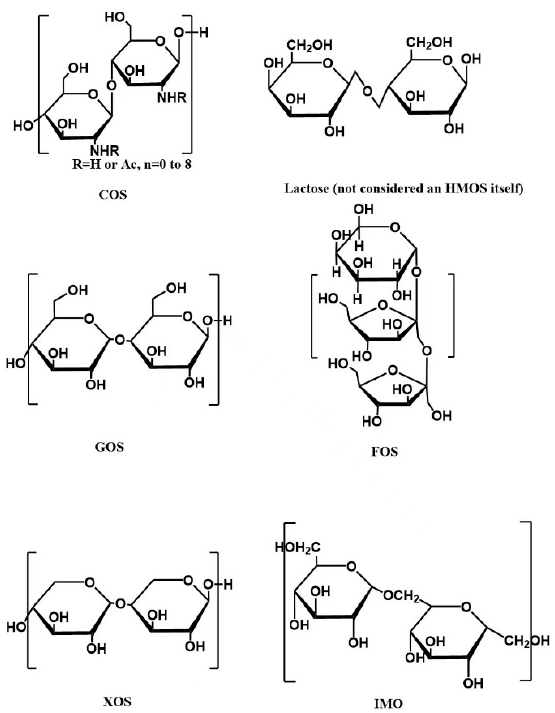
Figure 2. Schematic diagram of the structure of common functional oligosaccharides.